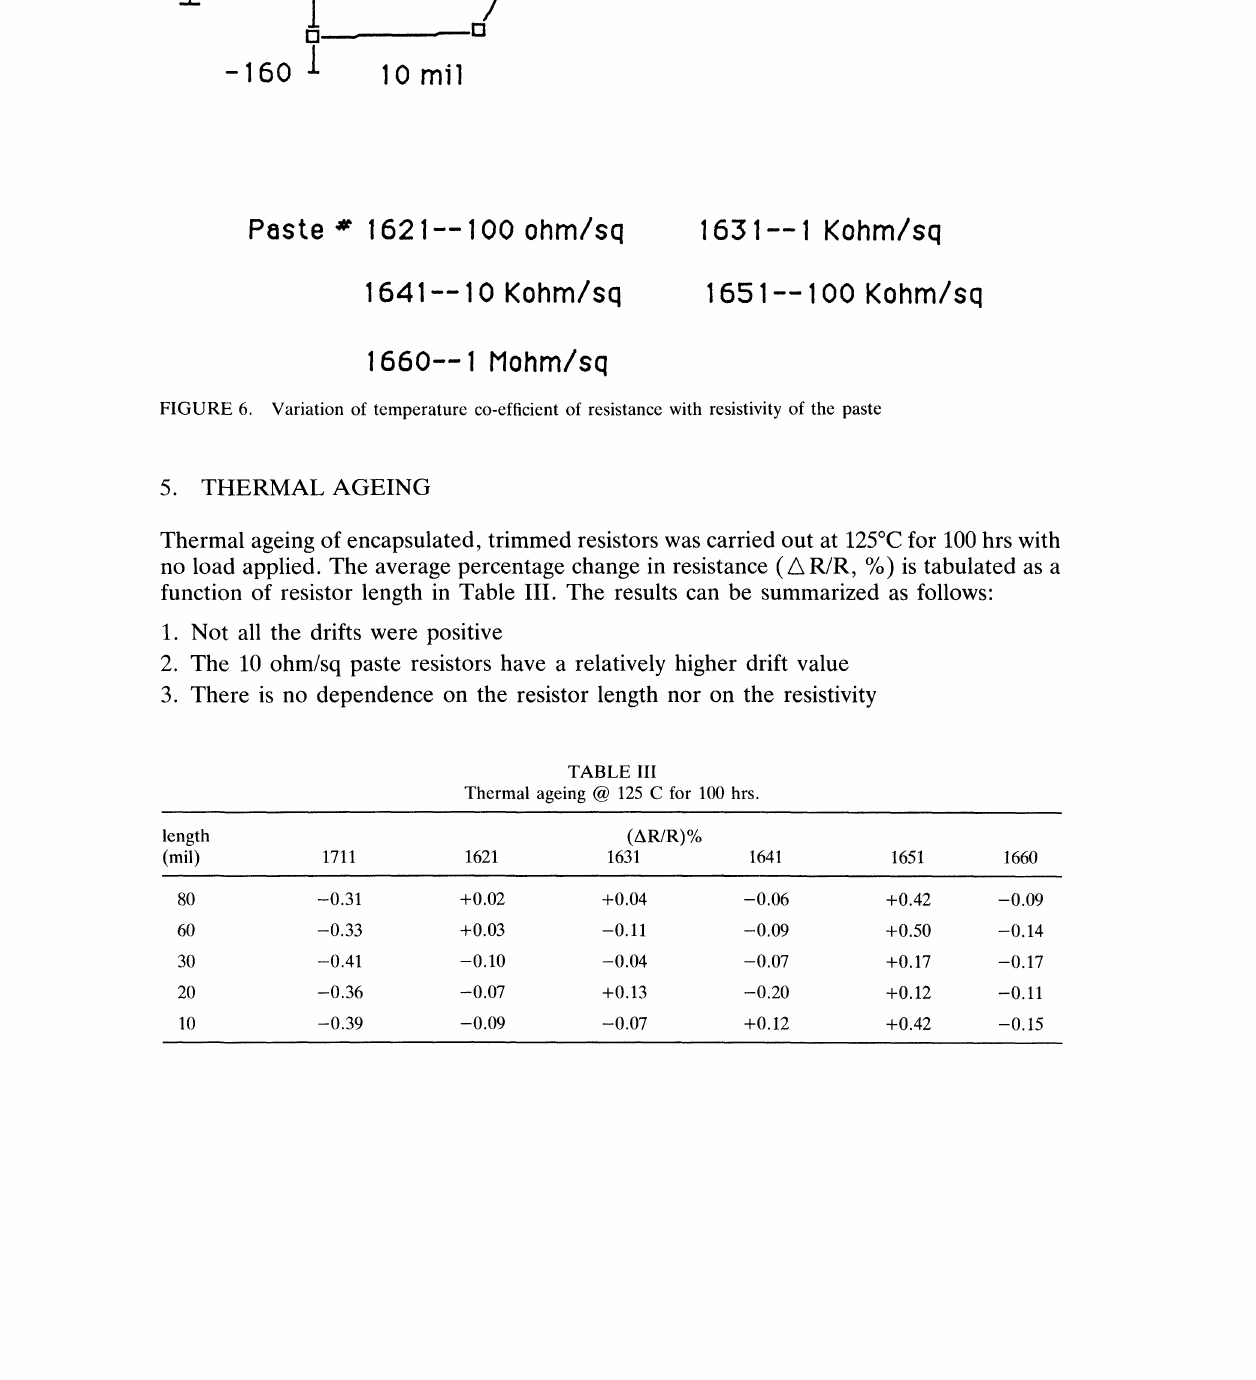
5. THERMAL AGEING